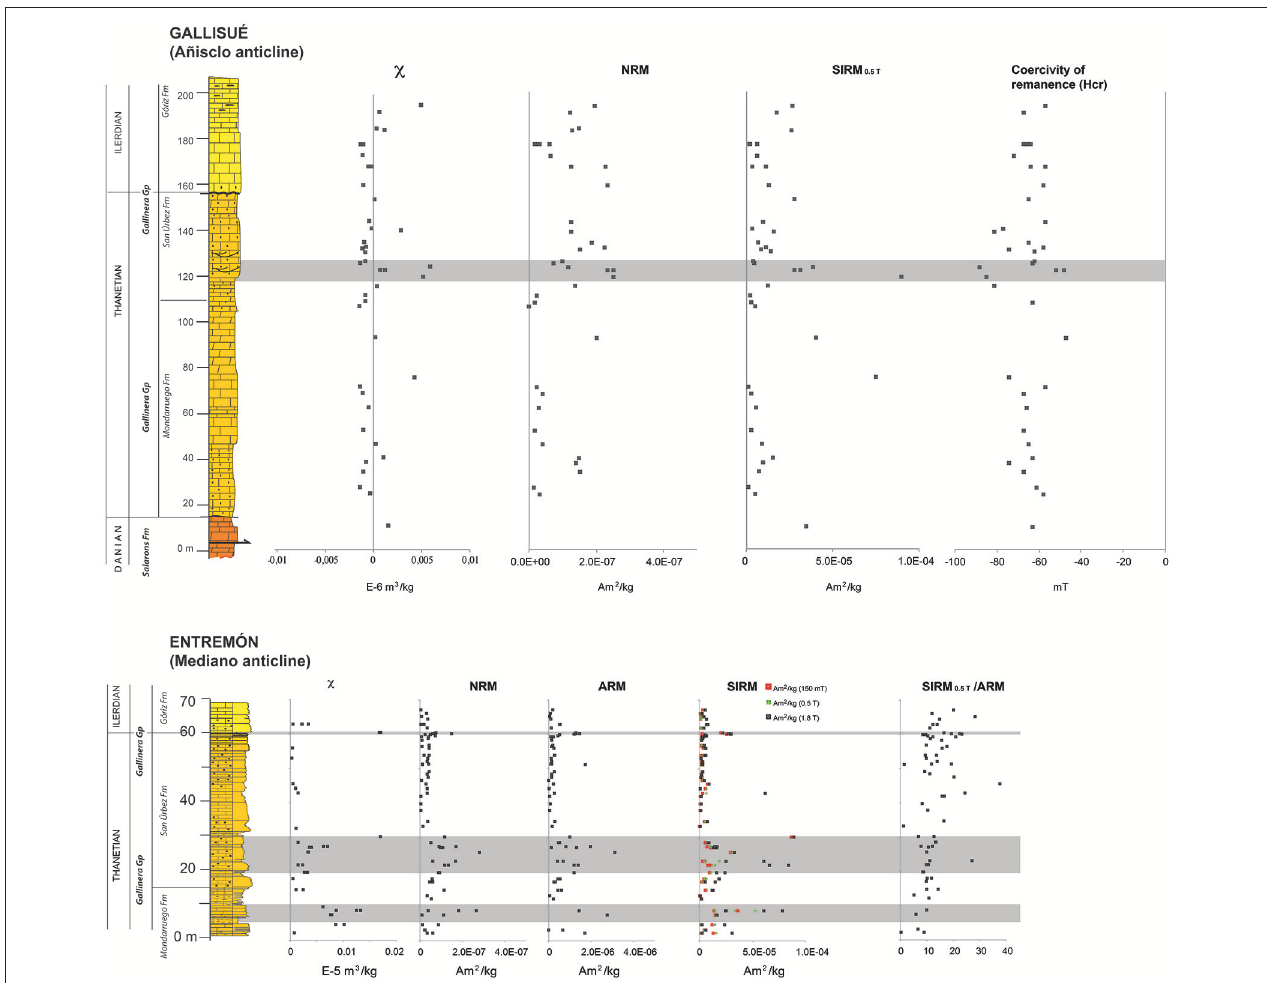
FIGURE 10 | Magnetic signal in the Gallisué and the Entremón sections. In Gallisué, bulk magnetic susceptibility, NRM, SIRM 0.5T , and coercivity of the remanence (mT). In Entremón, bulk magnetic susceptibility, NRM, ARM, SIRM, and SIRM 0.5T /ARM ratio. The colors of the SIRM column represent three different applied fields: in red, 150 mT, in green, 0.5T, and in gray, 1.8T. Gray bar marks higher values of ARM and/or SIRM. In the Entremón section, the top gray bar corresponds to the abiotic marly interval. Vertical scale is variable.